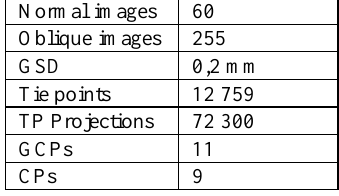
Table 4. Test area photogrammetric